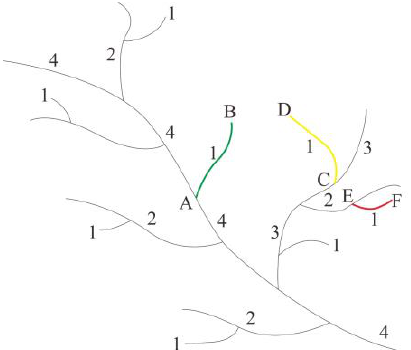
Figure 2. Inadequacies of current stream coding